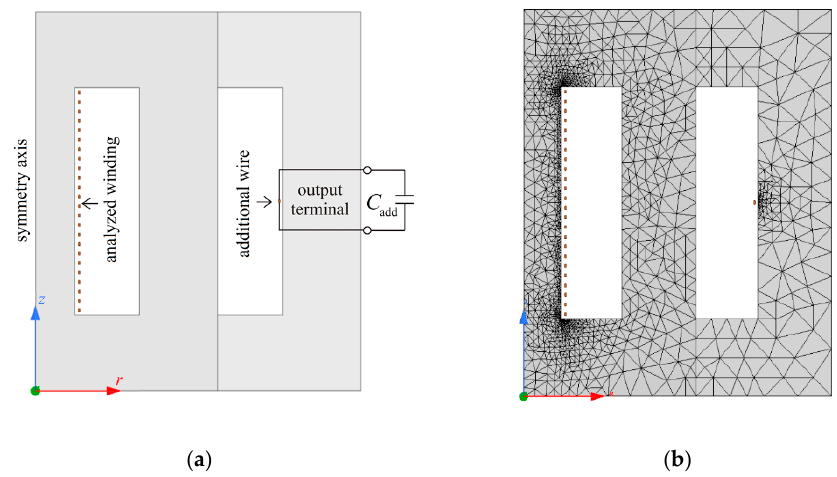
Figure 5. Two-dimensional (2D) coil model with additional circuit ( a ) and its discretization into finite element mesh ( b ).